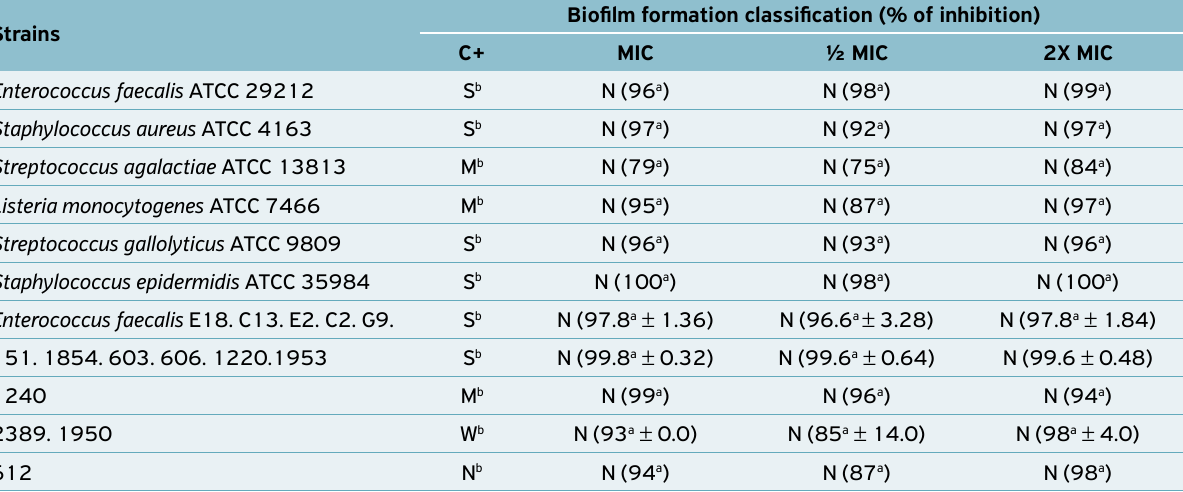
Table 4. Percentage of inhibition on the biofilm formation of gram‑positive strains exposed to essential oil of dried leaves of Eucalyptus staigeriana (EO dl ES).